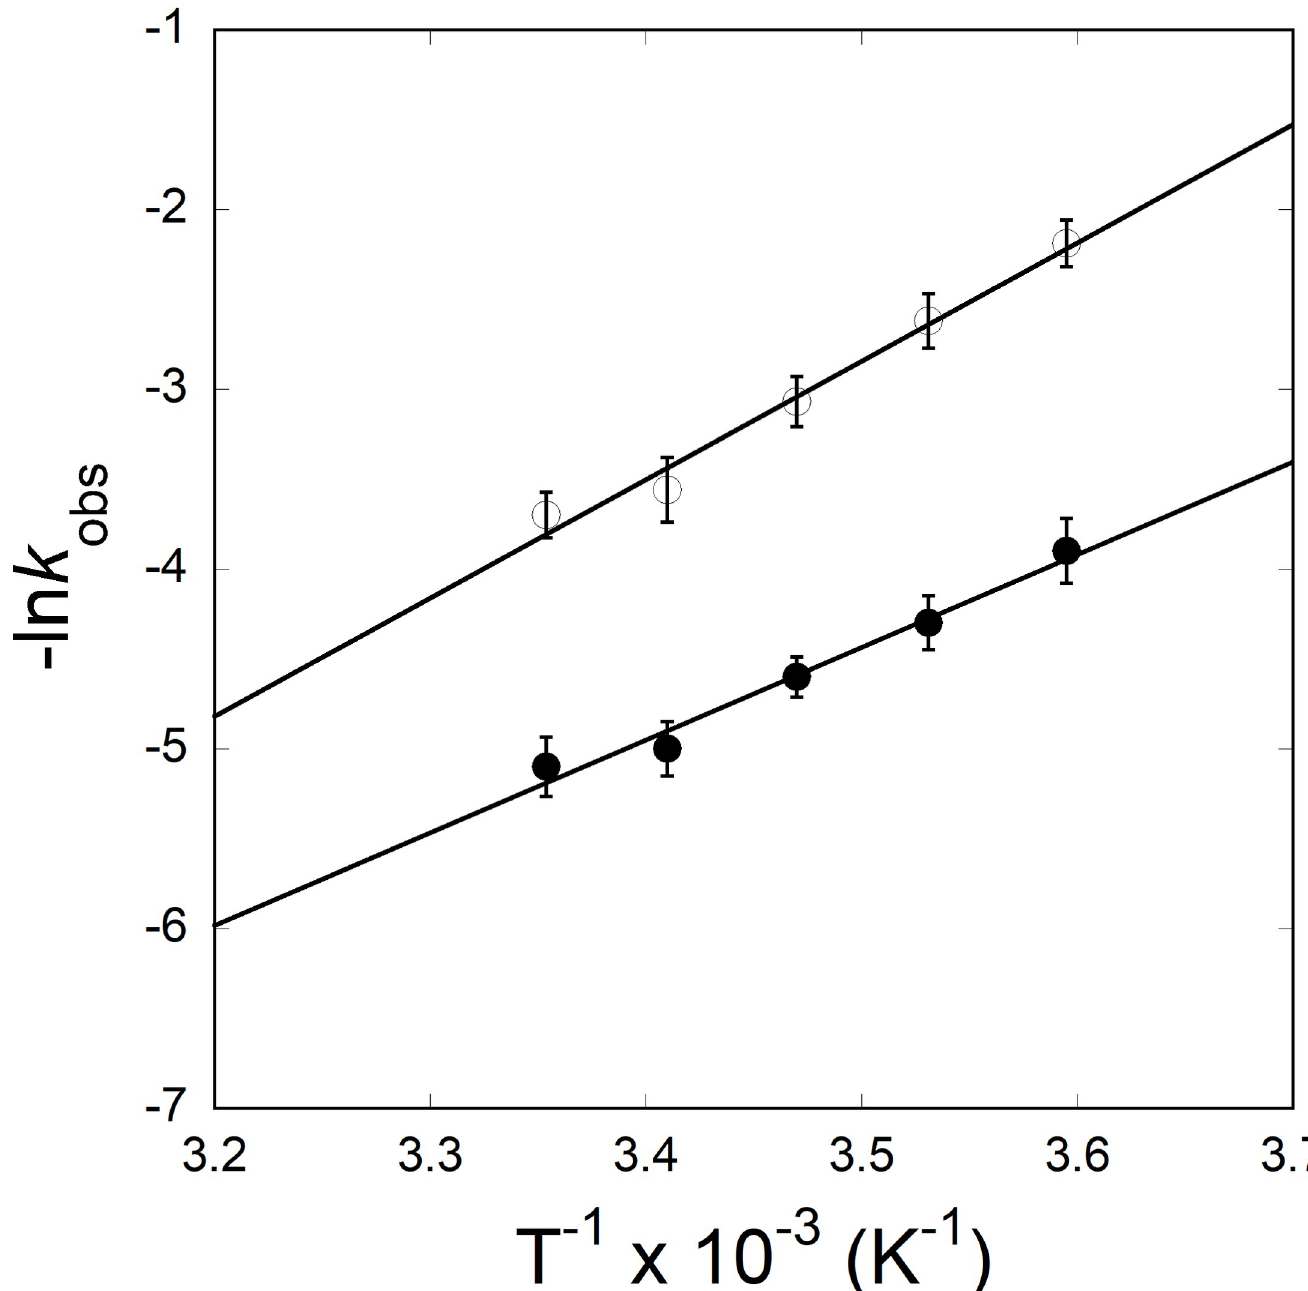
Fig 4. Arrhenius plots for the interaction of phosphorylated and unphosphorylated eIFiso4E with VPg. Dependence of k obs on temperature (278–298 K) for reaction conducted for eIFiso4Ep (—•—) and eIFiso4E (—o—), with VPg. Data are fit with Eq 3. The value of E a for the complexes were calculated from the slope of the fitted linear plot of ln k obs versus 1/ T (Kelvin) using least-squares fit of the data to a linear function. https://doi.org/10.1371/journal.pone.0259688.g004 conformation. The secondary structural contents were estimated as described previously [44, 60, 61]. Binding of VPg to eIFiso4Ep reduced the α -helix content to about 35% with an increase in the β -sheet content to about 25%. We observed decrease in the α -helicity values of eIFiso4Ep with addition of VPg. These changes in secondary structure reflect the eIFiso4Ep